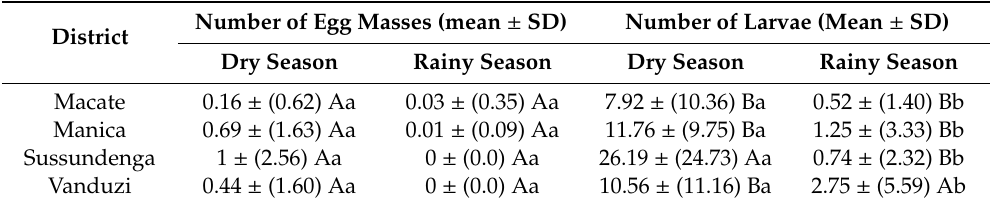
Table 3. Average number of fall armyworm (FAW) egg masses and larvae per field per district and season of